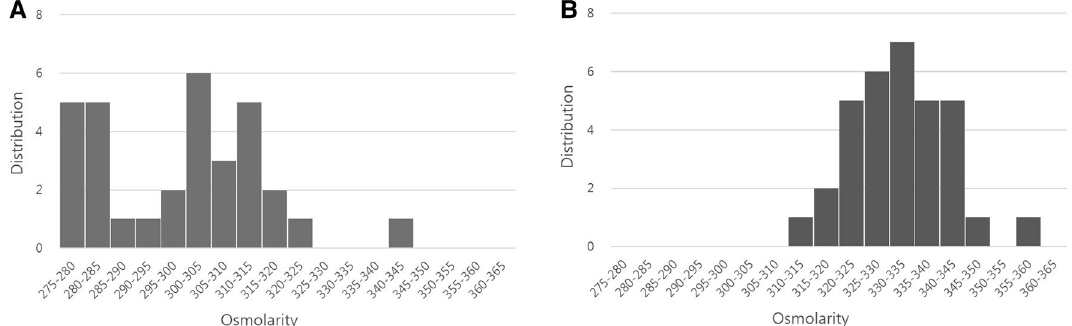
Figure 2. Distribution of osmolarity measured with the I-Pen osmometer. ( A ) distribution of osmolarity in the non-dry eye control group; ( B ) distribution of osmolarity in the dry eye disease group.